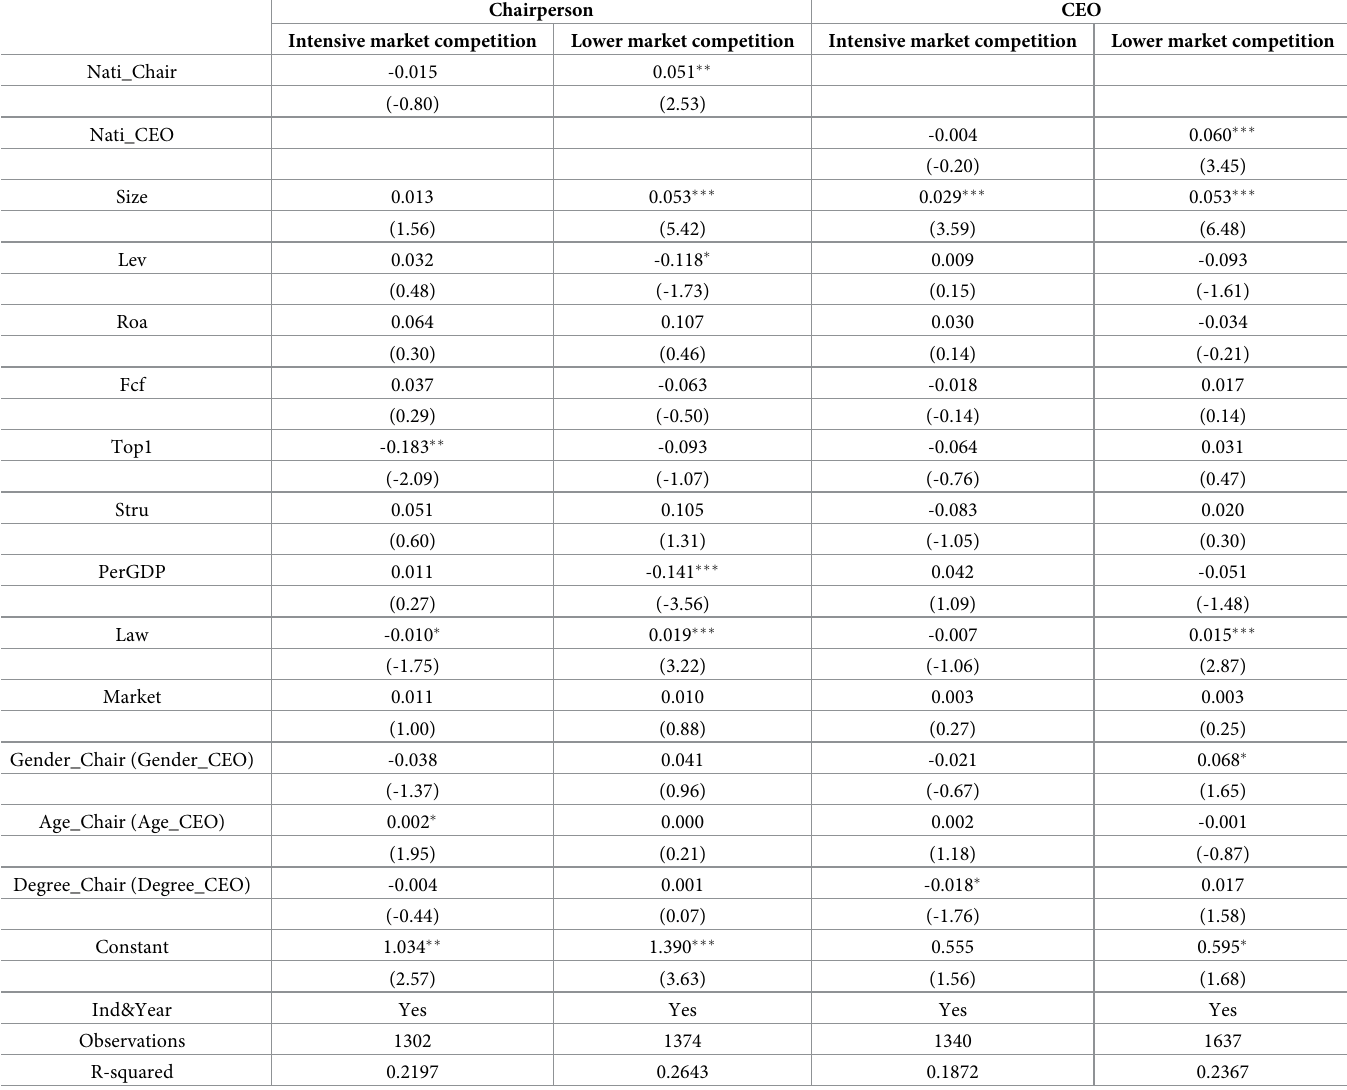
Table 11. Market competition, senior executive home bias and employee social